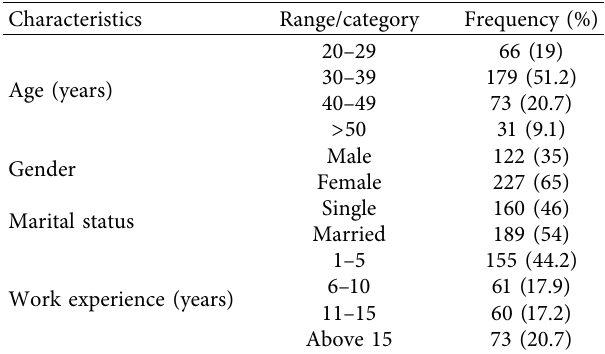
Table 3: Measurement model